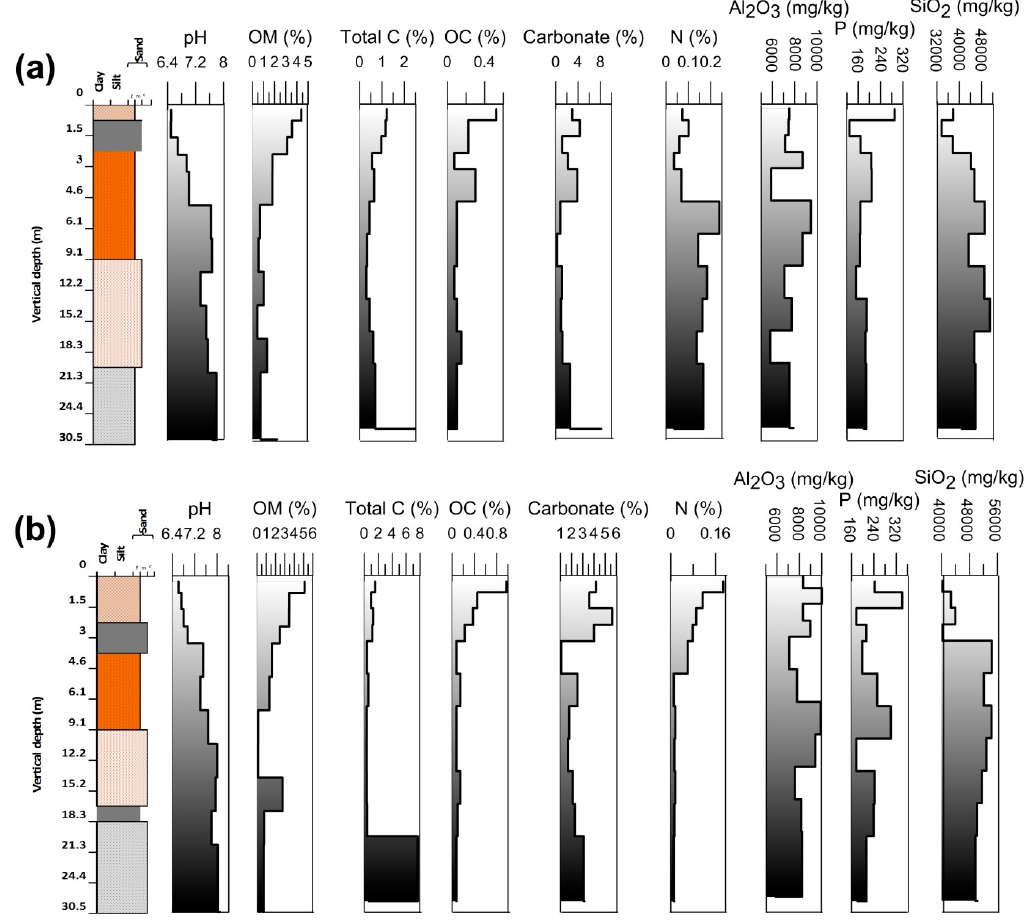
Figure 3. Physical parameters (pH, organic matter, total carbon, organic carbon, carbonate, N, Al 2 O 3 , P, and SiO 2 ) of core sediments ( a ) Rigni Chhapra ( b ) Chaube Chhapra.